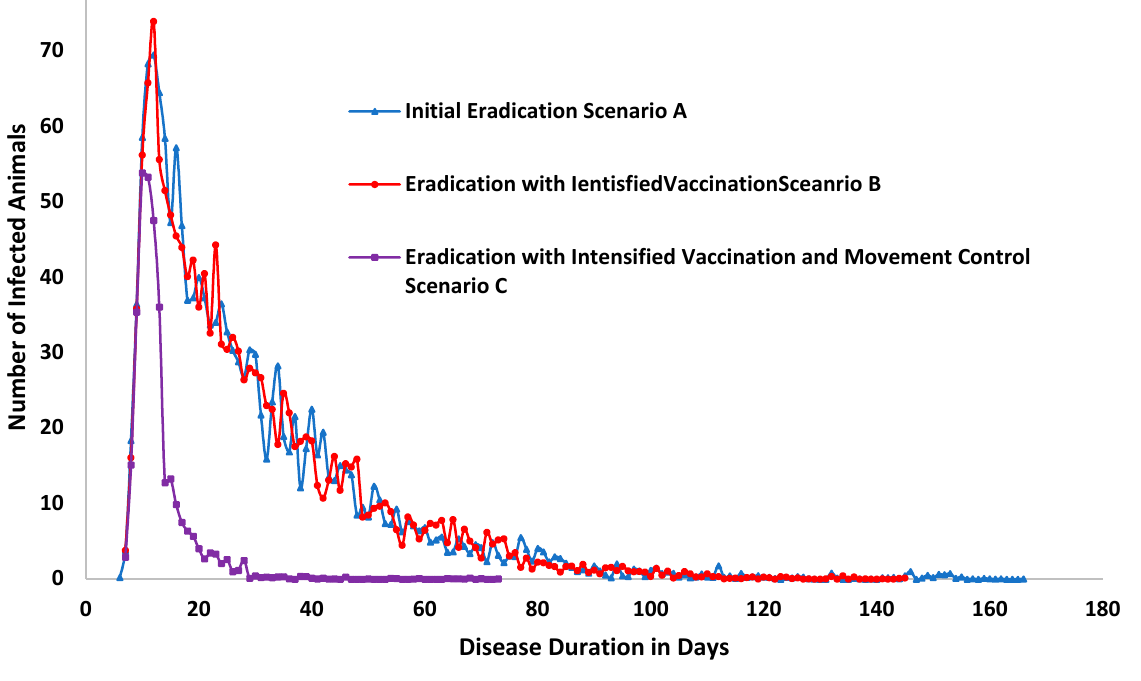
Figure 6. Absolute number of infected animals and outbreak duration in the three scenarios.